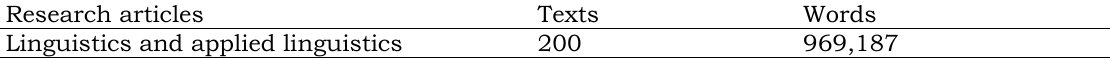
Table 1. Corpus of Research Articles Written by Indonesian Authors